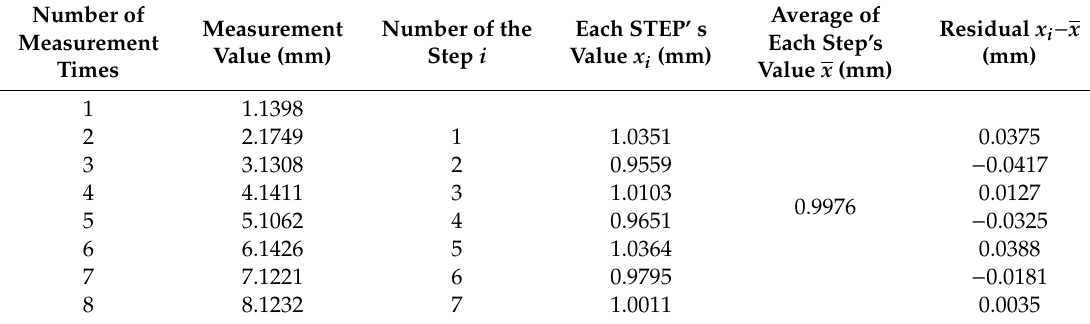
Table 3. Measurement results of the standard